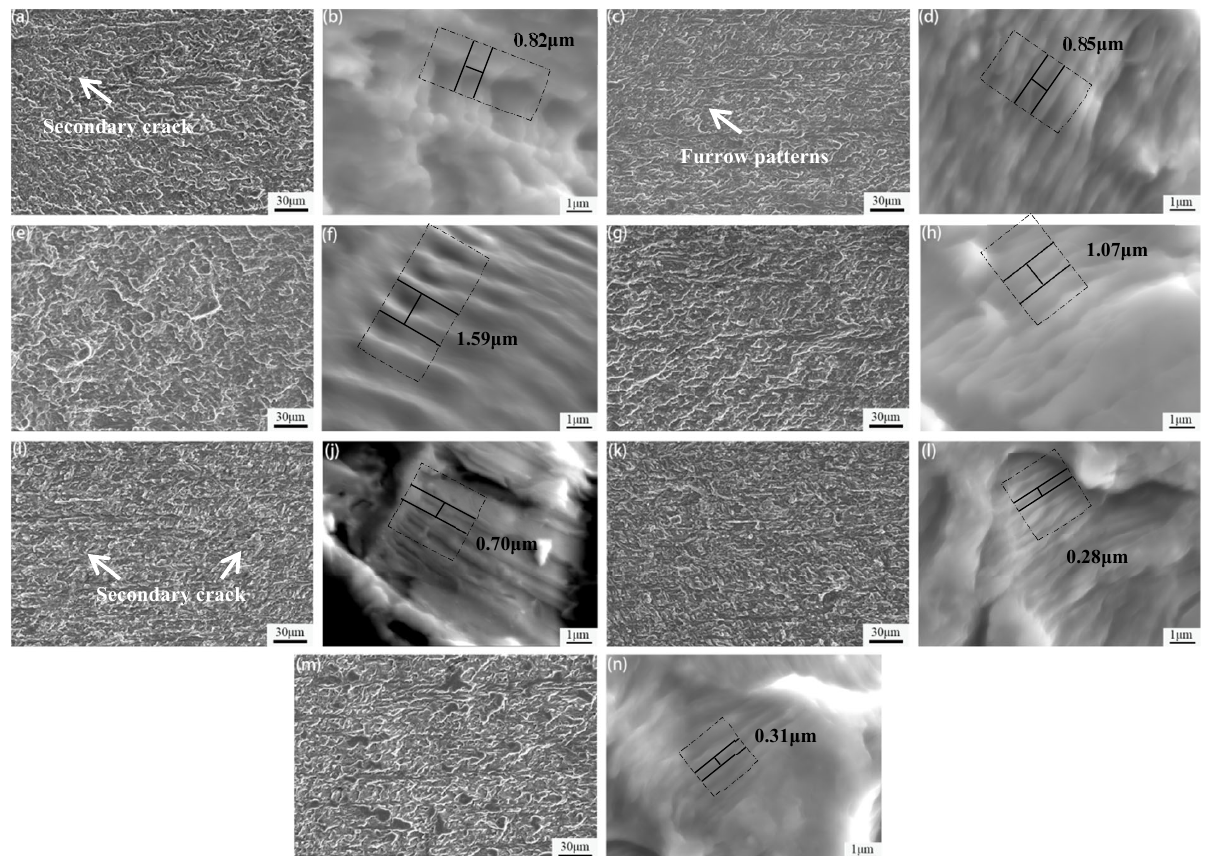
Figure 10. SEM images of fatigue fracture crack propagation in 7005 aluminum alloy plates aged at 120 °C for different durations: ( a , b ) 1 h, ( c , d ) 4 h, ( e , f ) 8 h, ( g , h ) 12 h, ( i , j ) 24 h, ( k , l ) 96 h, and ( m , n ) 192 h.